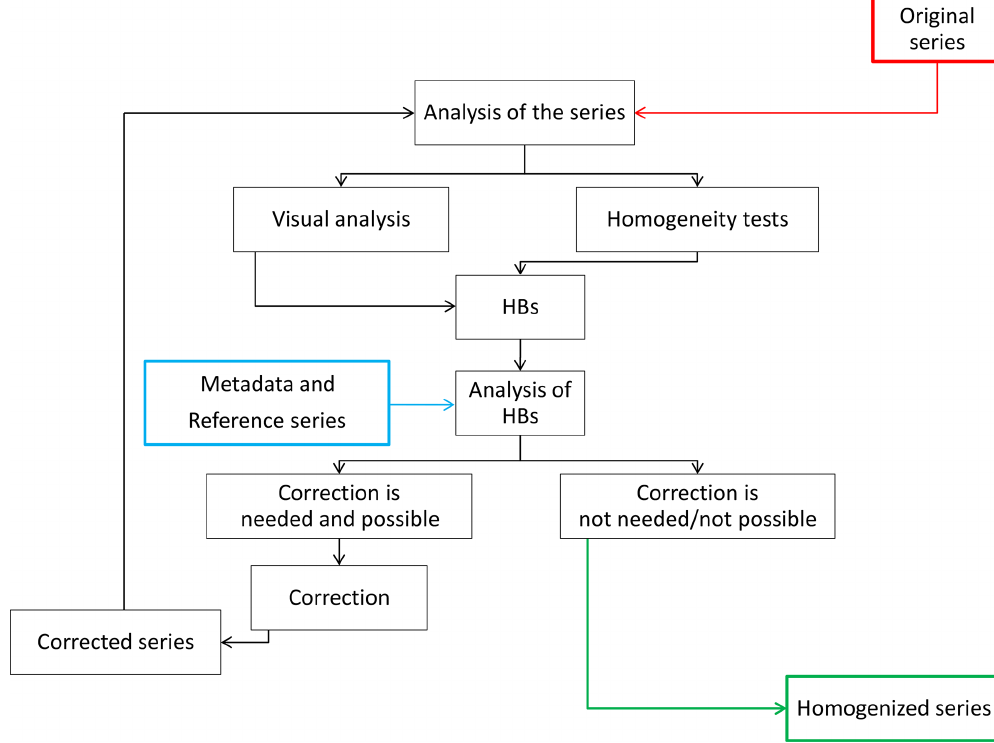
Figure 6. Homogenization